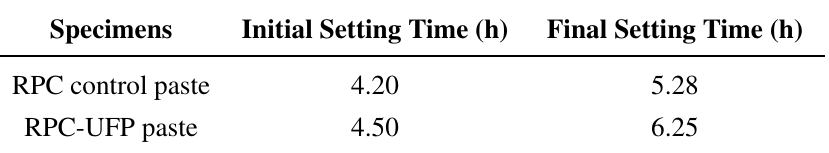
Table 6. Initial and final setting time of reactive powder concrete (RPC) control and RPC-UFP pastes. Specimens